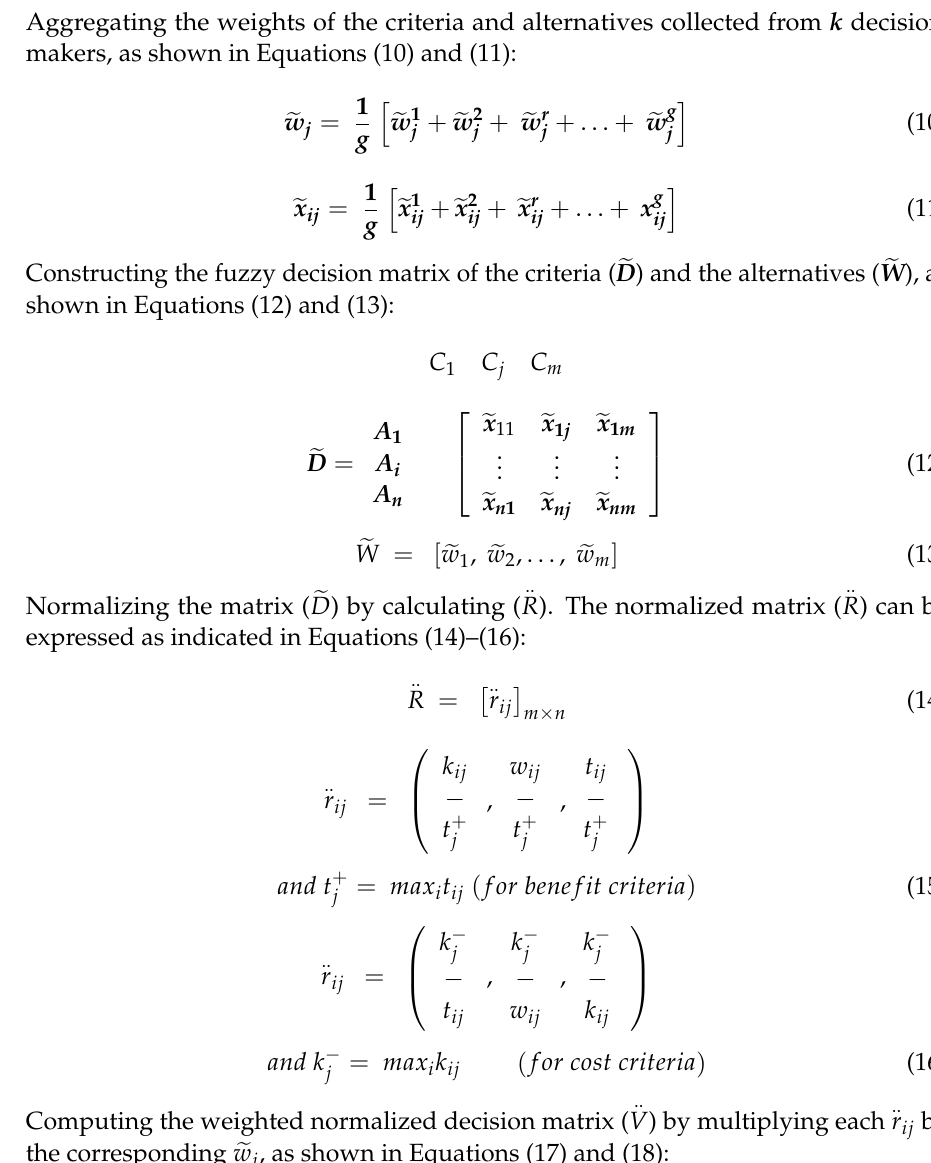
4. Computing the weighted normalized decision matrix ( the corresponding (cid:101) w j , as shown in Equations (17) and (18):